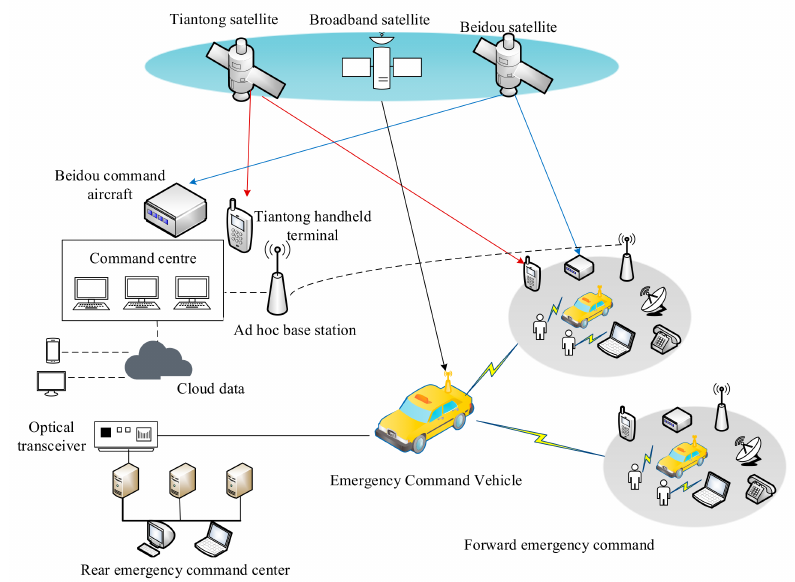
Figure 9. Network structure of mobile satellite